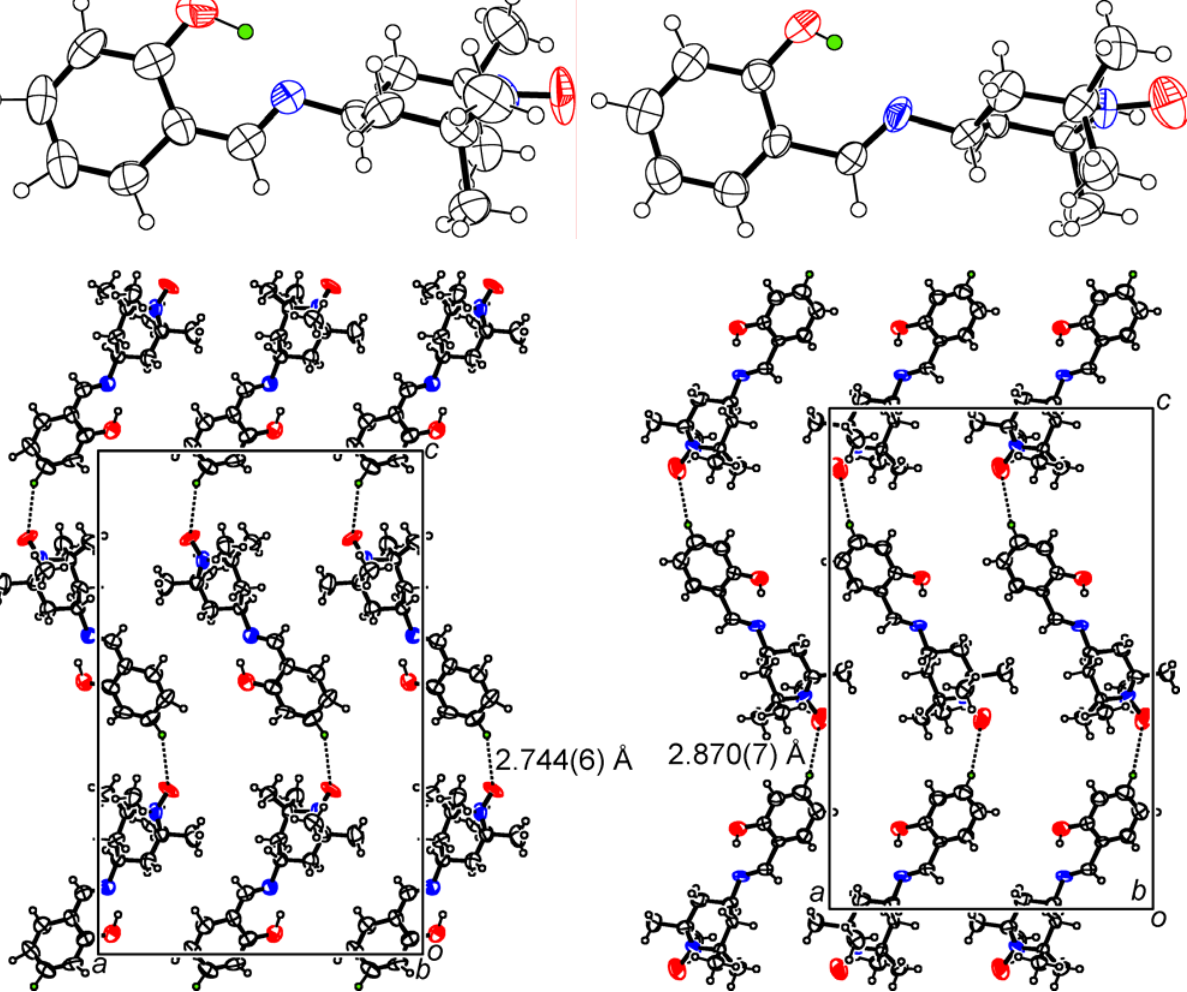
Figure 2. Upper: molecular structures of 2a (left: molecule A, right: molecule B). Lower: sheet-like structures in the crystal structure of 2a (left: a sheet from molecules A, right: a sheet from molecules